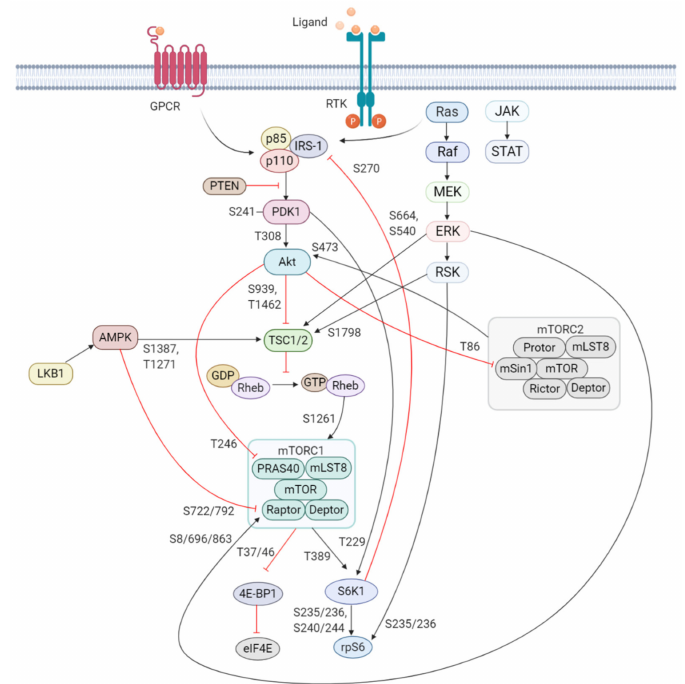
Figure 1. Schematic overview of the activation and regulation of the PI3K / Akt / mTOR signaling pathway. Activation of PI3K is stimulated by binding of an extracellular ligand (e.g., hormones, growth